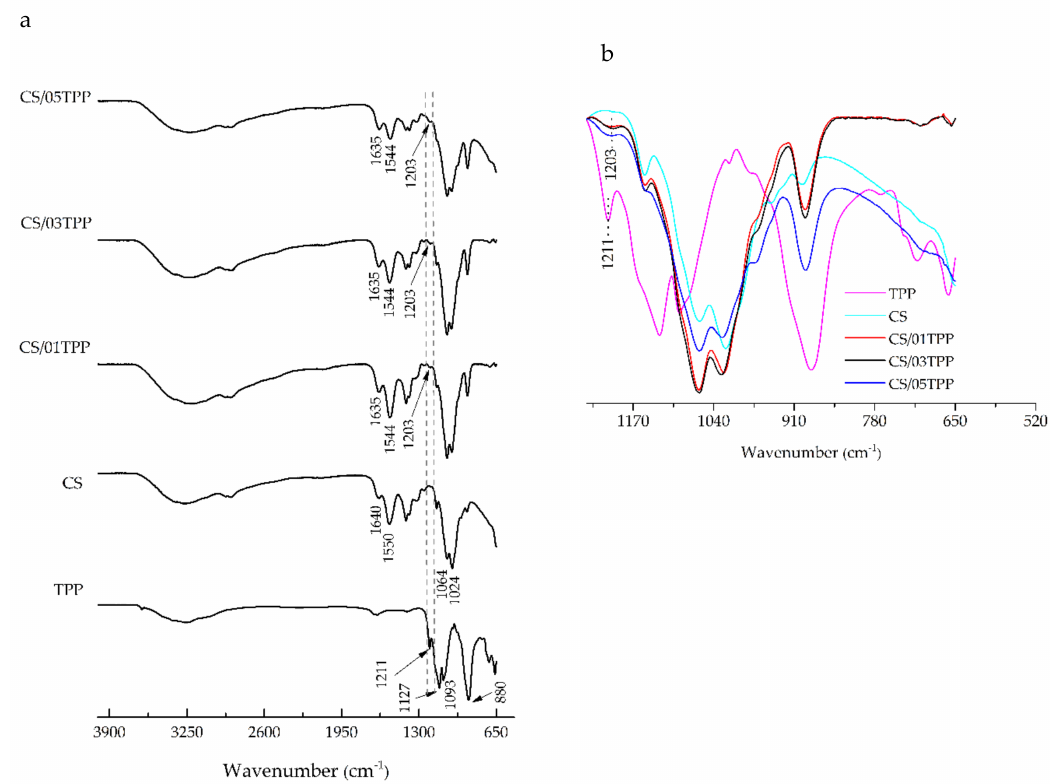
Figure 1. Fourier transform infrared (FTIR) spectra of sodium tripolyphosphate (TPP), non-crosslinked and ionically crosslinked chitosan membranes ( a ) from 4000–500 cm − 1 and ( b ) from 1245–520 cm − 1